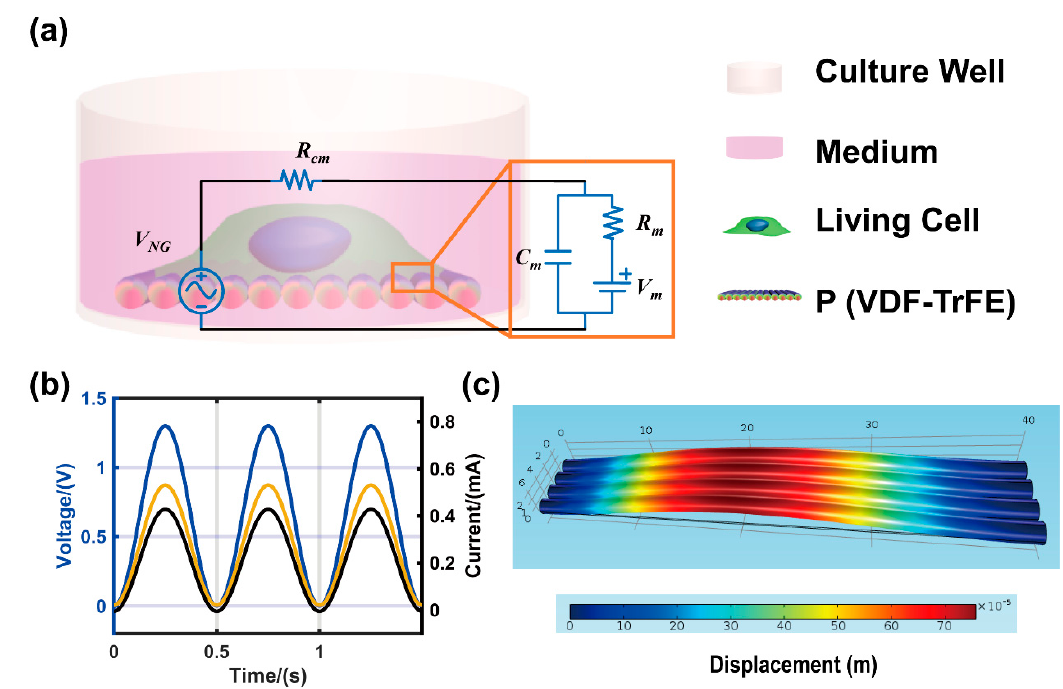
Figure 6. Electrical model of the NG-cell and FEM model of NG. ( a ) The diagrammatic sketch of NG-cell and corresponding equivalent circuit model. ( b ) The voltage (yellow) and current (black) applied to the cell membrane due to sinusoidal voltage stimulation (blue). ( c ) FEM stimulation of deformation distribution of nanofibers on NG at the stress amplitude of 0.5 Mpa.